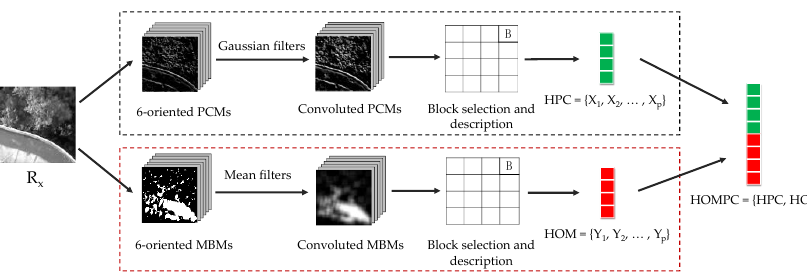
Figure 4. The main processing chain of the HOMPC descriptor. The black dotted line box and red dotted line boxes respectively indicate the construction process of the histograms of oriented phase consistency (HPC) and the histograms of magnitudes (HOM). The HOMPC is made up of them. Remote Sens. 2018 , 10 , x FOR PEER REVIEW